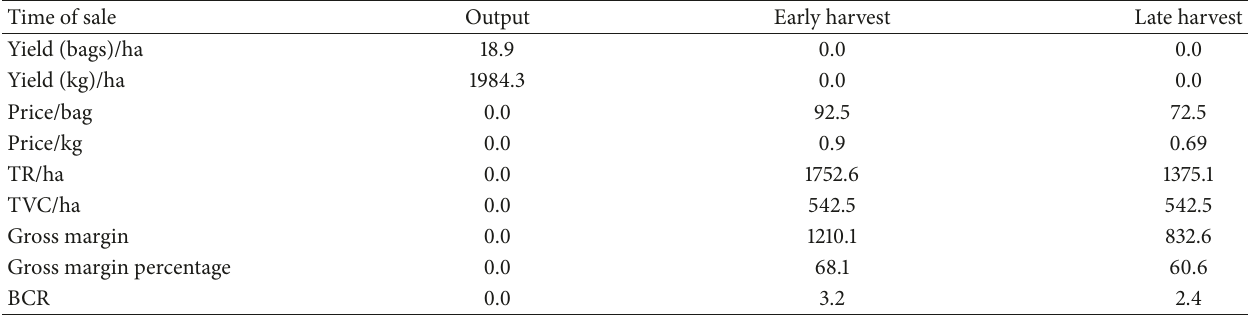
Table 5: Output and revenue at early and late harvest seasons of sweet potato.